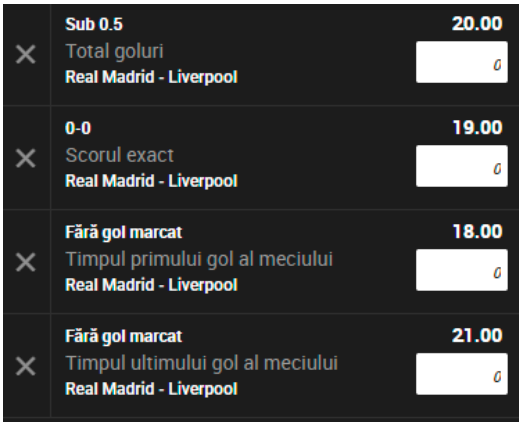
Figure 17. Different odds for the same bet. Source: Authors’ processing is based on data available on unibet.ro (accessed on 20.02.2020).